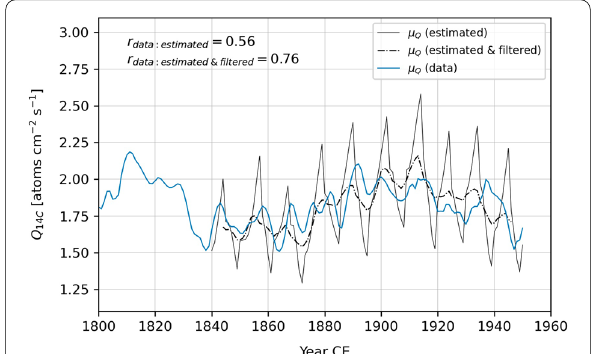
Fig. 4 A comparison between the 14 C production rate data and theoretically expected 14 C production rates. The theoretical estimate of the mean global 14 C production rate (black line) for the period 1840–1950 CE was based on φ GSN and COV-OBS. 2. The dash-dotted × line depicts the estimated 14 C production rate after being filtered with a 9-year moving average filter. The 14 C production rate based on IntCal20 (blue line) was normalized to have the same mean as the filtered 14 C production rate for the overlapping period. The correlation coefficients between the 14 C production rate modeled from the data and the filtered or non-filtered estimates of 14 C production rate are